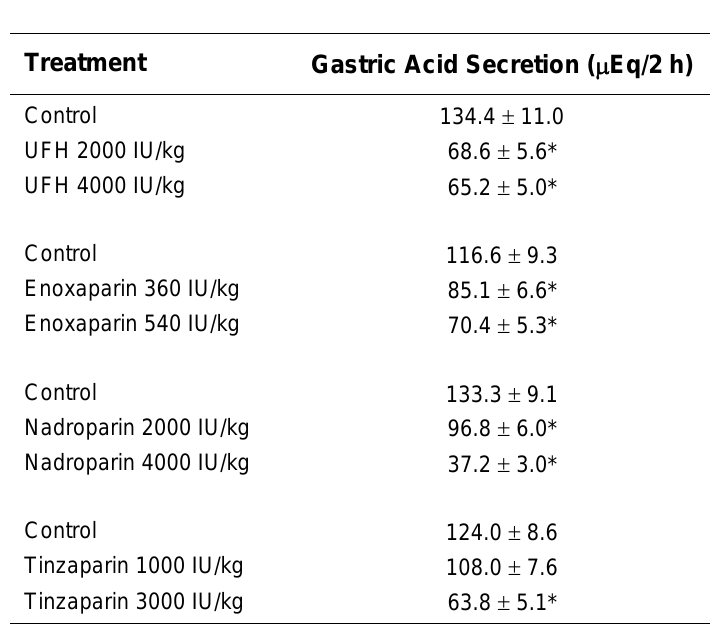
Inhibition of Gastric Acid Secretion Stimulated by Distention and Bethanechol (1.5 mg/kg, i.p.) by by UFH and LMWHs in